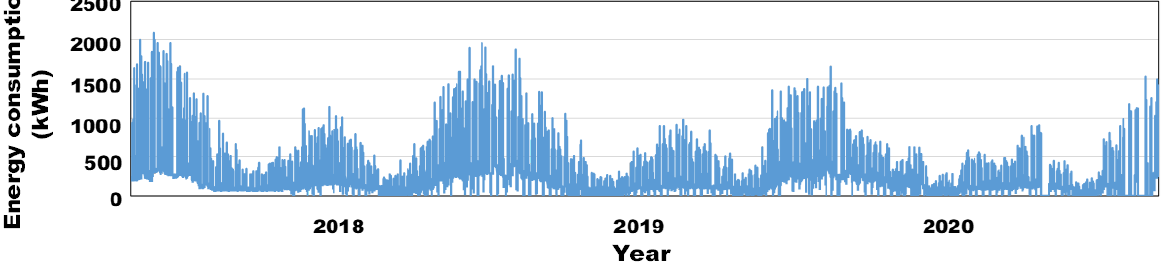
Figure 2. Energy consumption of the A community buildings for three consecutive years.